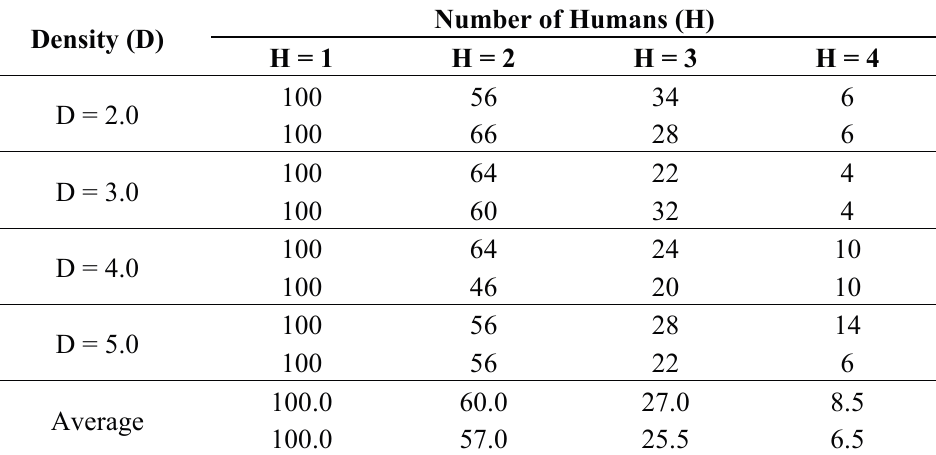
Table 2. Success estimation rate (Unit: